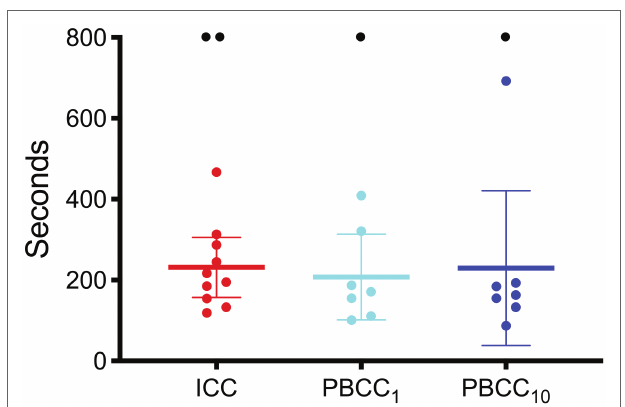
FIGURE 1 | Time to return of spontaneous circulation in immediate cord clamping (ICC; red), Physiologically-based cord clamping, PBCC 1 (light blue) and PBCC 10 (dark blue) lambs. Individual animals are shown with mean (95% CI)